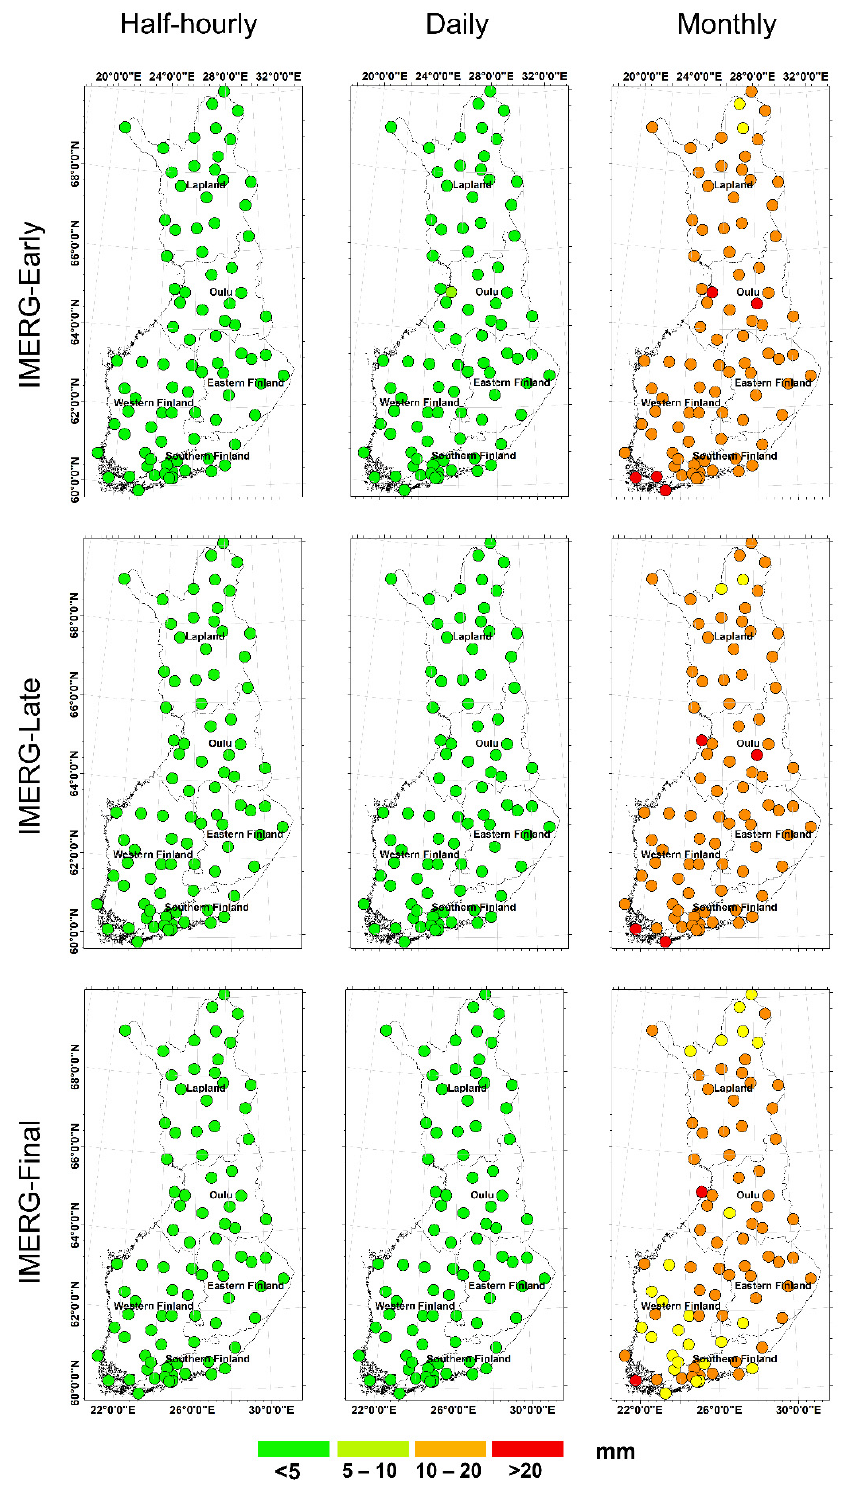
Figure 15. Spatial distributions of the half-hourly, daily, and monthly MAE for IMERG-Early, IMERG- Late, and IMERG-Final.